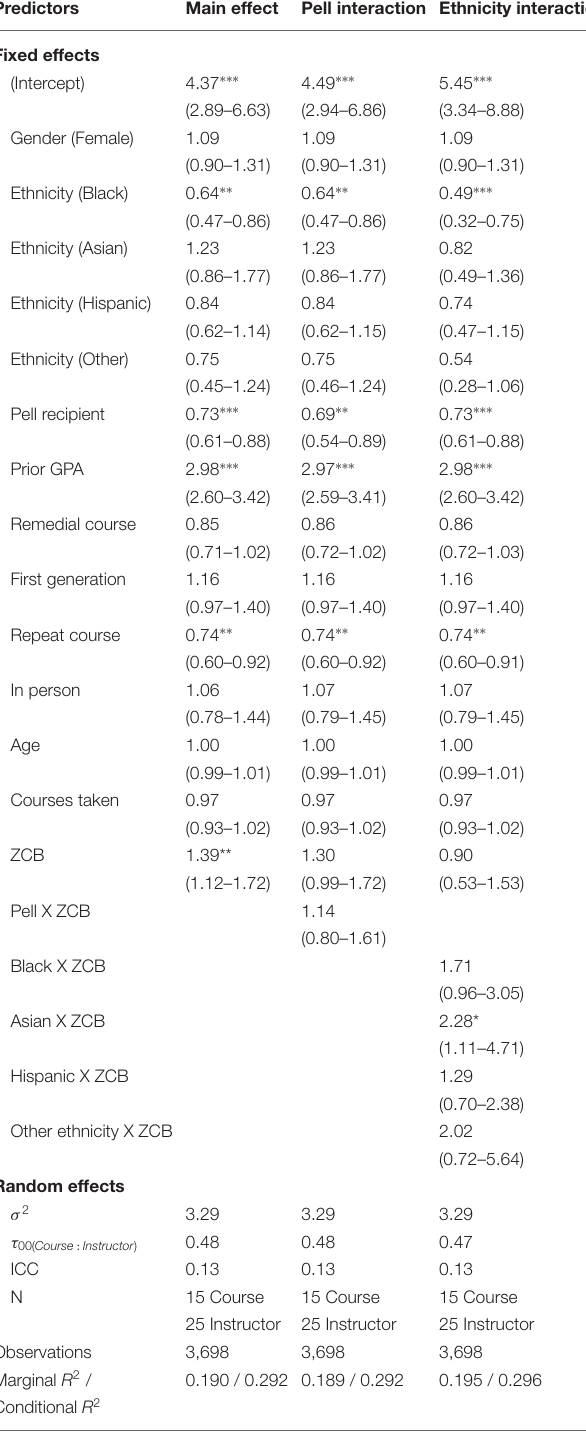
TABLE 3 | Regression results for predicting passing a